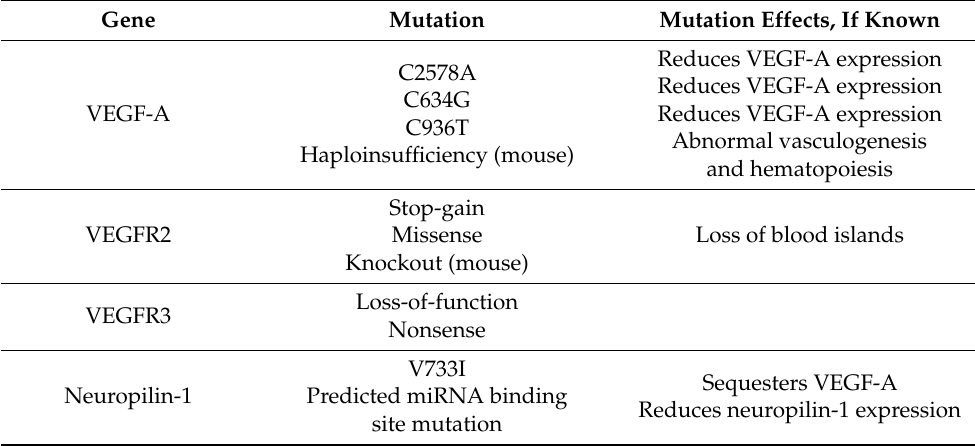
Figure 5. VEGF and sempahorin (Sema) ligands bind to a variety of heterodimer receptors, and co-receptor Neuropilin-1 can heterodimerize with both VEGF and plexin receptors, leading to extensive cross-talk between pathways. Neural crest cells (yellow) express the membrane-bound semaphorin 6, which directs their migration toward specific plexin receptors. (Created with BioRender). Table 1. Mutations associated with tetralogy of